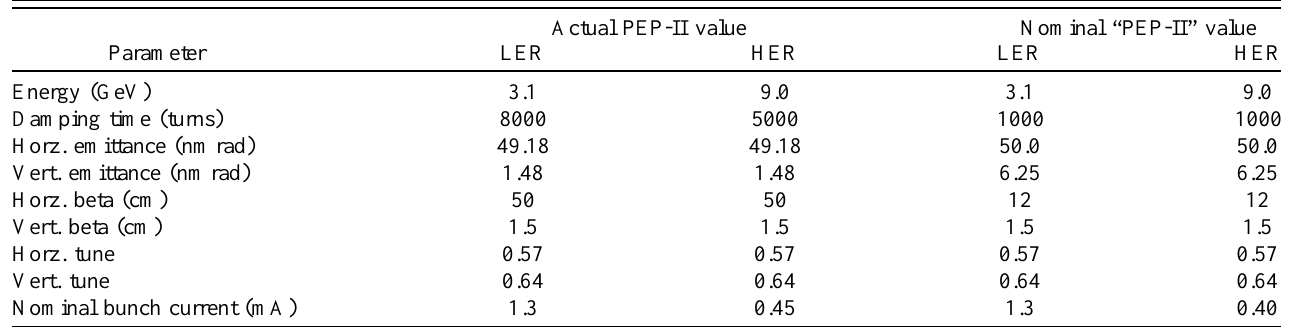
TABLE I. Parameters for PEP-II: design parameters (column 2) as well as those used in the simulations (column